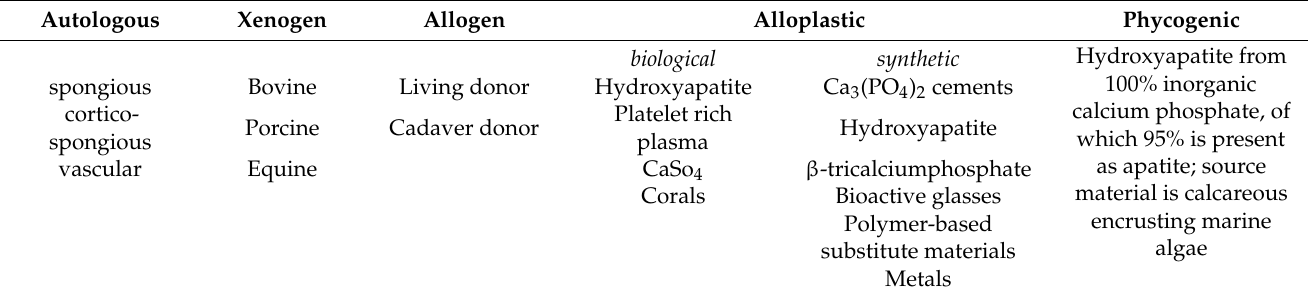
Table 1. Summary of bone graft substitutes [8,9]. Bone graft substitutes are differentiated terminolog- ically according to their origin. Composites of the individual substitute materials are not